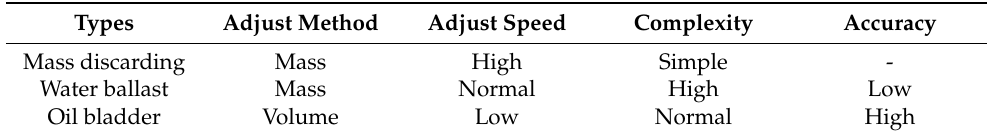
Table 1. Comparison of mass discarding, water ballast and oil bladder